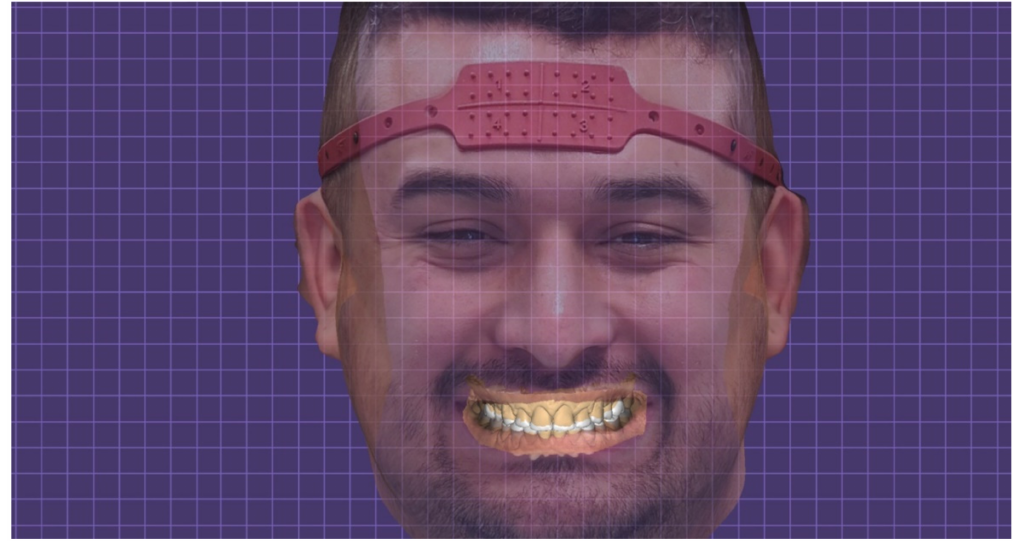
Figure 10. STL Digital wax-up integrated with 3D facial scan.